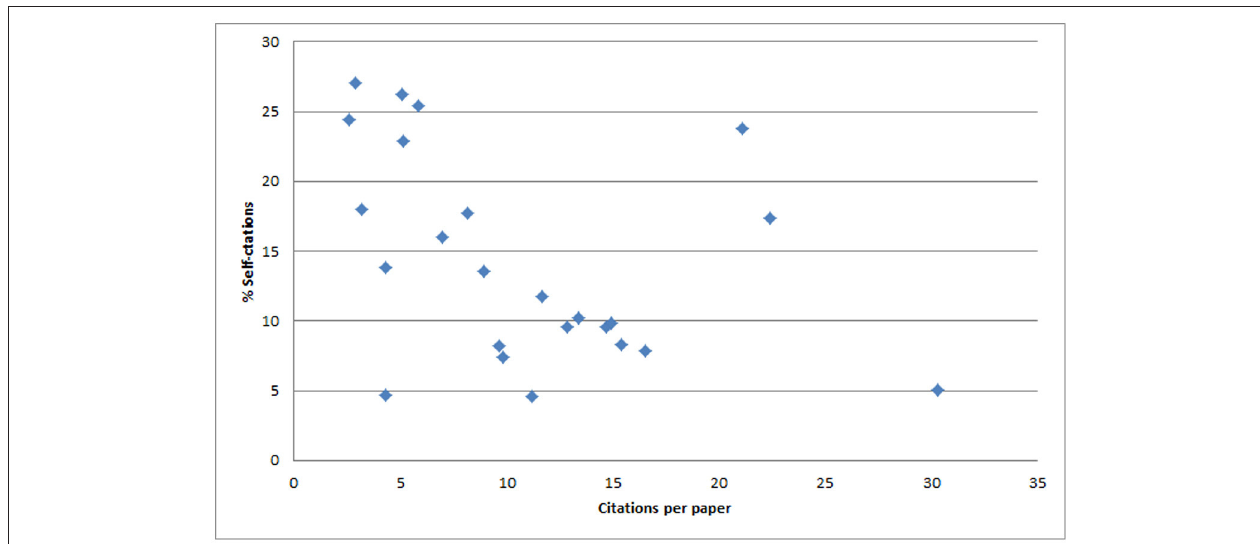
FIGURE 3 | Relationship between external citation and self-citation in the scientific production of Spanish researchers in the Web of Science category “Infomation Science and Library Science” (2001–2015).